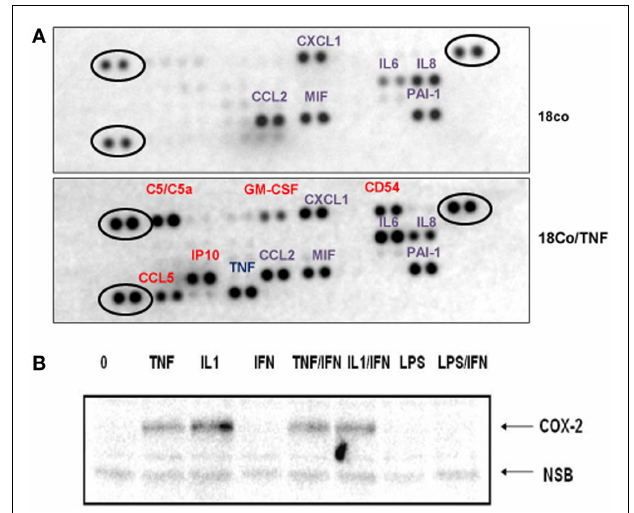
FIGURE 3 |Activation of 18Co cells withTNF stimulates the synthesis of a number of protumorigenic factors. (A) 18Co cells were left untreated or were treated withTNF for 24h and the proteome profiler antibody array (R&D Systems) was performed. Circled are positive controls. (B) 18Co cells were stimulated withTNF, IL1, IFN γ , or LPS as indicated and the amount of COX2 was determined by